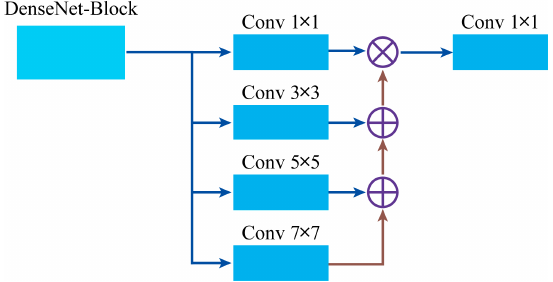
Figure 2. The architecture of the local attention unit.